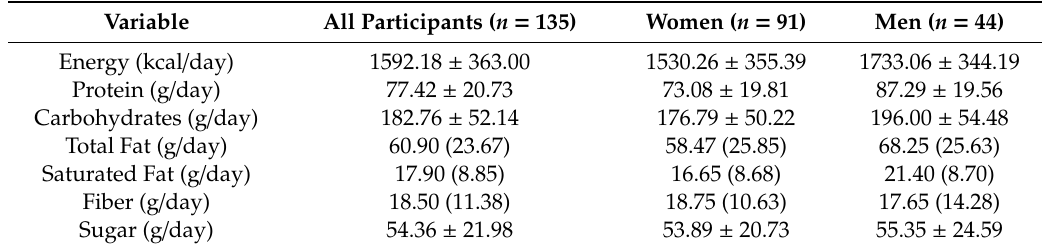
Table 2. Average macronutrient intake calculated from the 14-day food